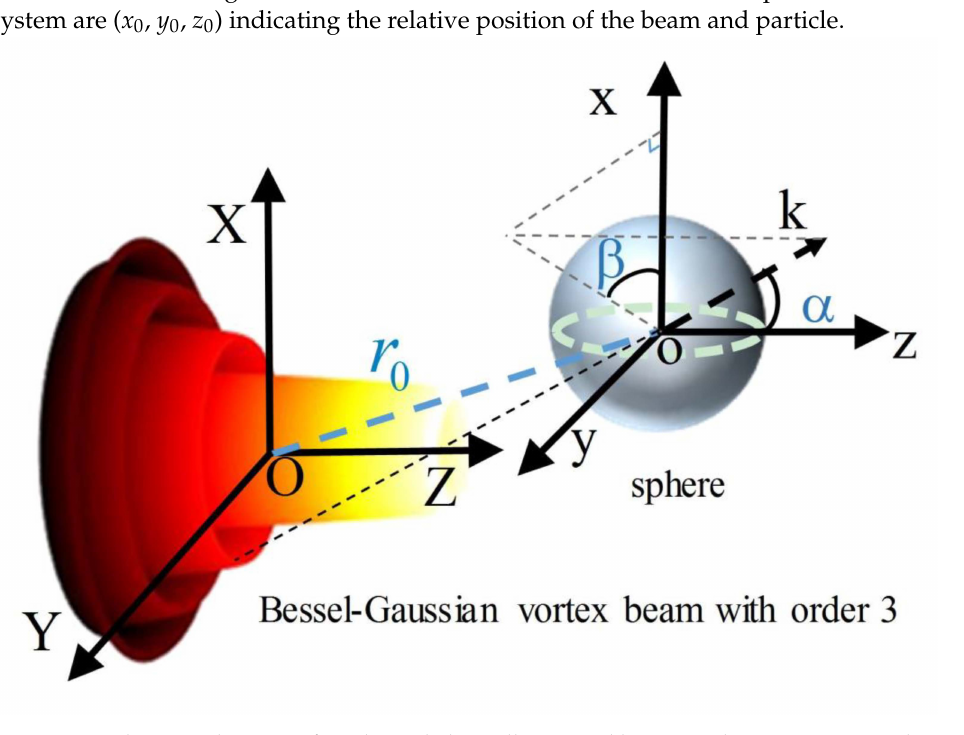
Figure A1. Schematic diagram of a spherical object illuminated by a Bessel–Gaussian vortex beam. The expression of the electric field of a vector Bessel–Gaussian beam with order l at the source plane